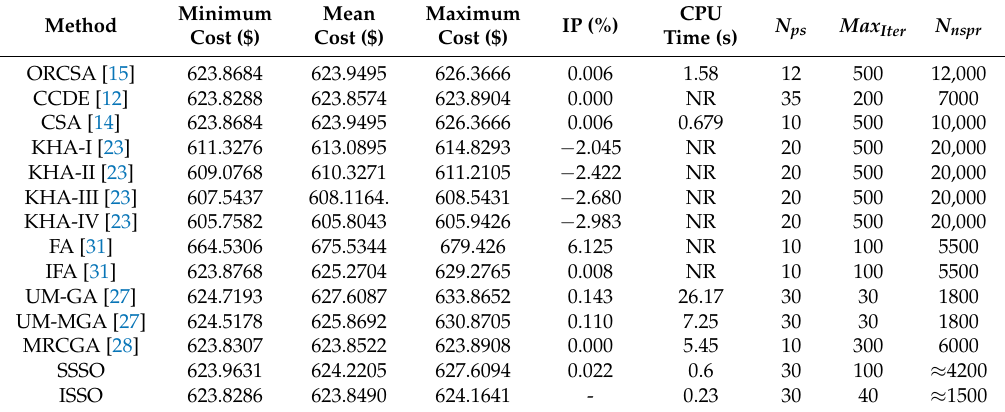
Table 4. Result summary obtained by different methods and the proposed method for case 1 of system 2.